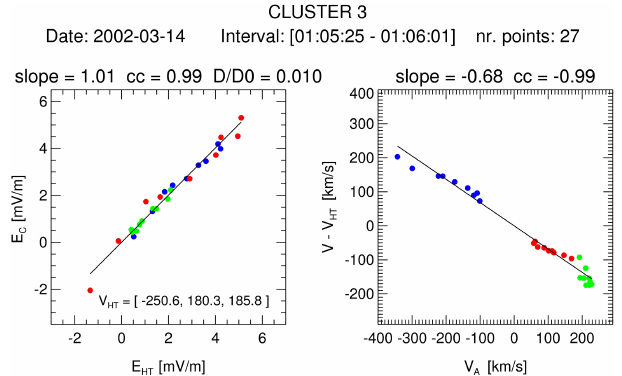
Figure 3. Left: plot of the GSE components of the convection elec- tric field, E c = − V × B , versus the corresponding components of the deHoffmann–Teller electric field, E HT = − V HT × B . Right: scatterplot of the components of v (cid:48) ≡ ( V − V HT ) versus the com- ponents of V A . In both plots the x , y , and z components are shown in blue, green, and red,